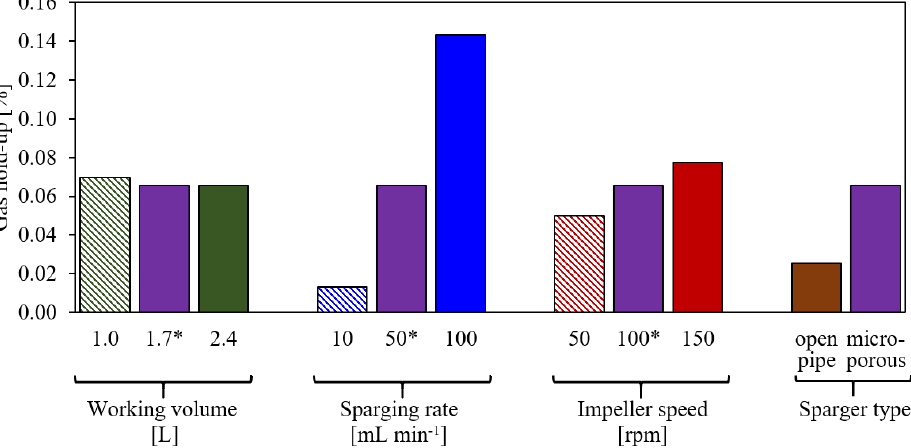
Figure 5. Simulated gas hold-up for the different test conditions given in Table 1. Labels on the abscissa show the modified parameters compared to the base